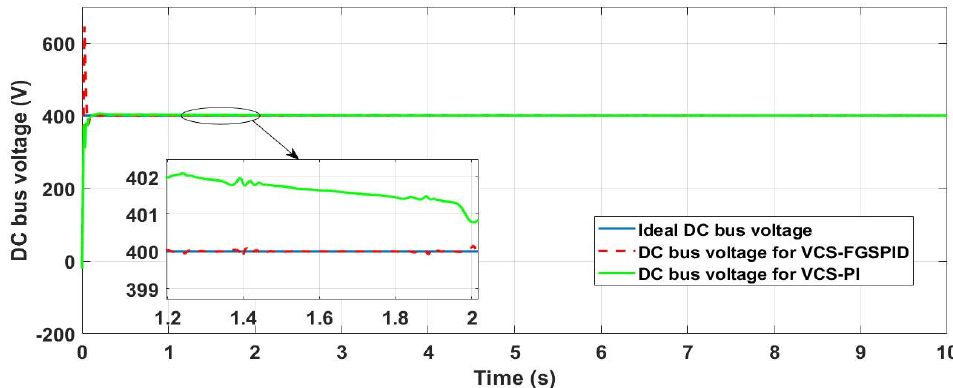
Figure 39. Hardware co-simulation for direct grid current.